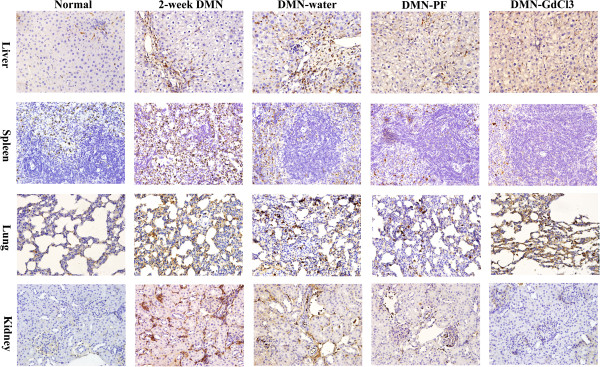
Effects of PF on CD68 using immunohistological staining in different organs in DMN-induced rat liver fibrosis. CD68 was investigated by brown staining indicates immunopositivity ×400 magnification, n=3.